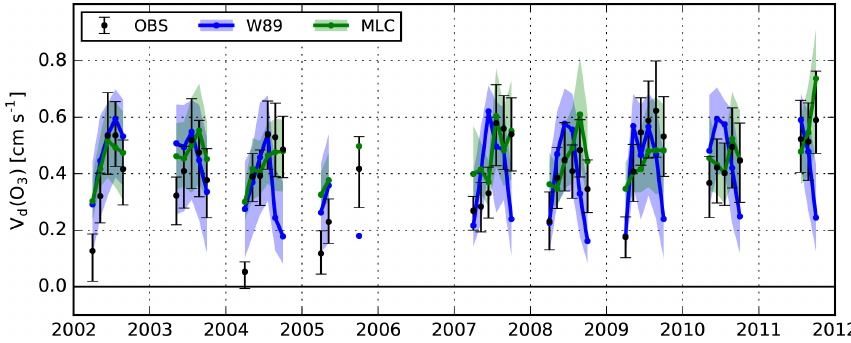
Figure 3. As in Fig. 2 but for